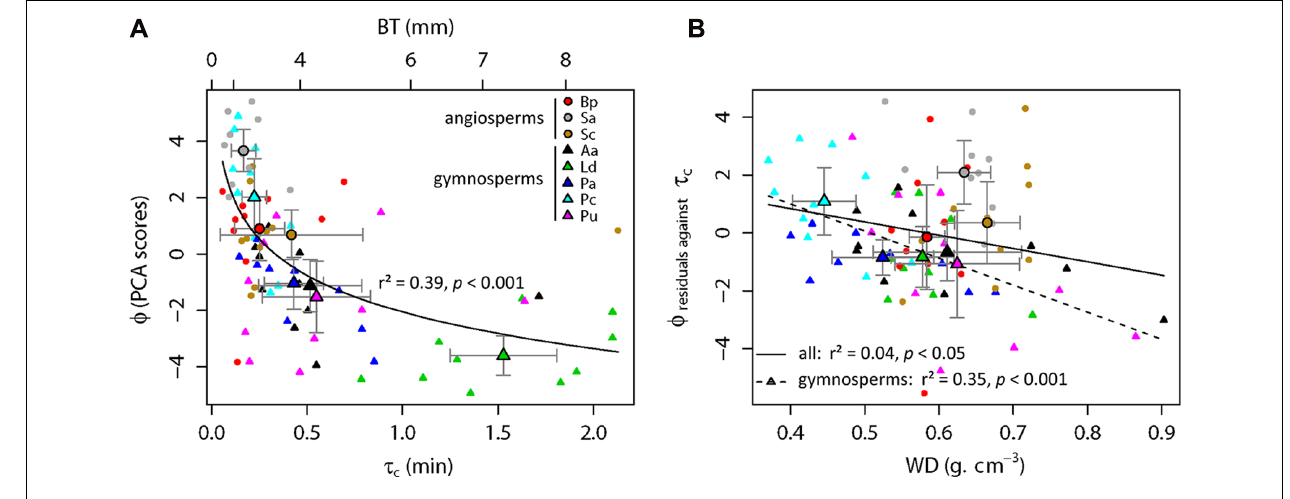
A) , regression residuals were used to explore relationship between φ and wood density (WD, B ) among all trees (straight line, p < 0.05) and among gymnosperms (dashed line, p < 0.001). Species means and standard errors are indicated by larger symbols and bars, respectively.